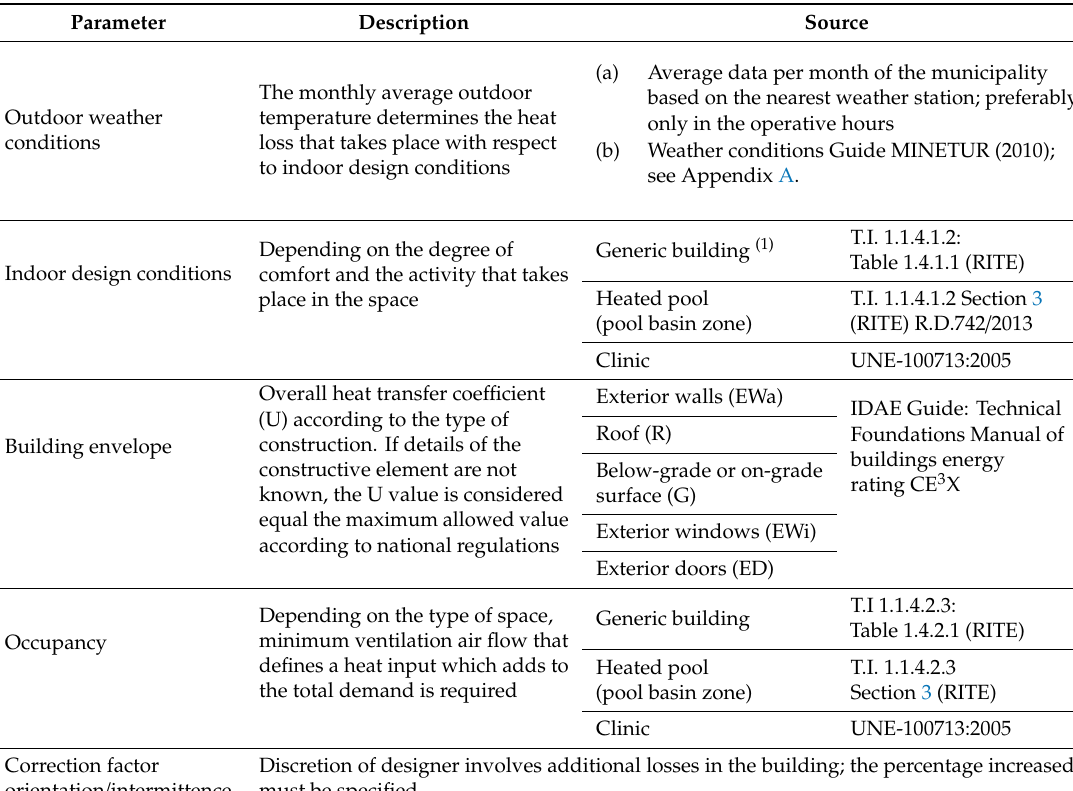
Table A1. Parameters for heating